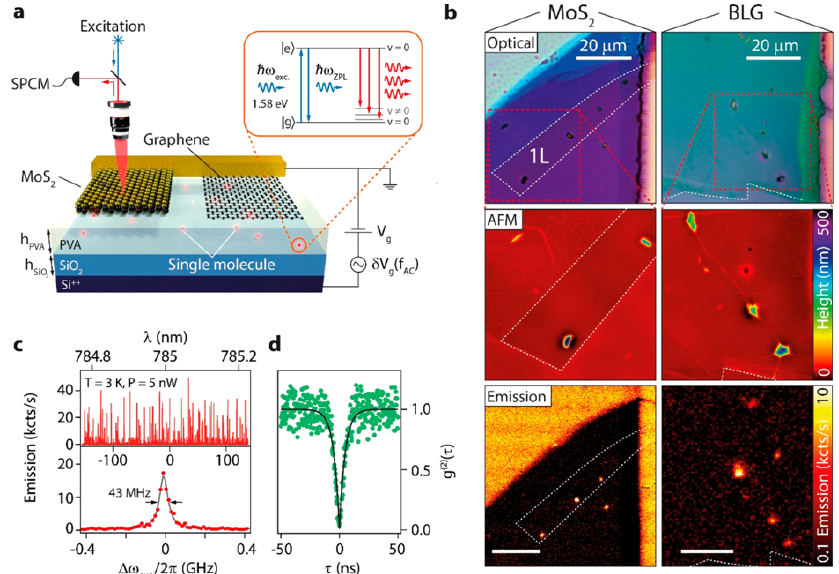
Figure 17. Single molecules integrated with 2D materials. ( a ) Hybrid device schematic. Atomically thin layers of graphene and MoS 2 cover fluorescent molecules embedded in a PVA film (h PVA = 300 nm) on SiO 2 (h SiO2 = 285 nm). Single molecules are resonantly excited (inset) and their red-shifted fluorescence detected with a single-photon counting module (SPCM). Electric fields are controlled by applying DC (V g ) and AC ( δ V g ) potentials to the Si ++ back gate. ( b ) Top to bottom: optical micrograph, AFM topography, and DBT emission map for MoS 2 (left column) and bilayer graphene (right column) devices. White dashed lines outline the flakes. Scale bars are 20 μ m. ( c ) Top panel: fluorescence excitation spectrum of an ensemble of single molecules in an uncovered nanocrystal at 3 K. Bottom panel: detail of two emission peaks with Lorentzian line shape (solid line), the narrower peak shows a fwhm of 43 ± 7 MHz. ( d ) Antibunching measurement for resonant excitation of a single peak as shown in part c. The solid line is a fit to the data using a second-order correlation function. Reprinted (adapted) with permission from Ref. [73]. Copyright (2019) American Chemical Society.